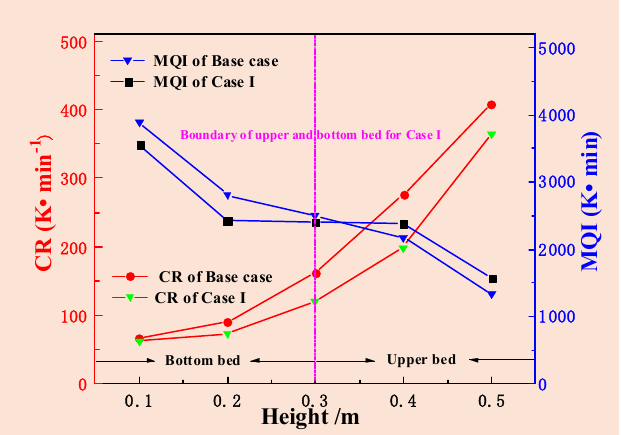
Figure 12. Comparison of CR and MQI for FSDS and CS technology.